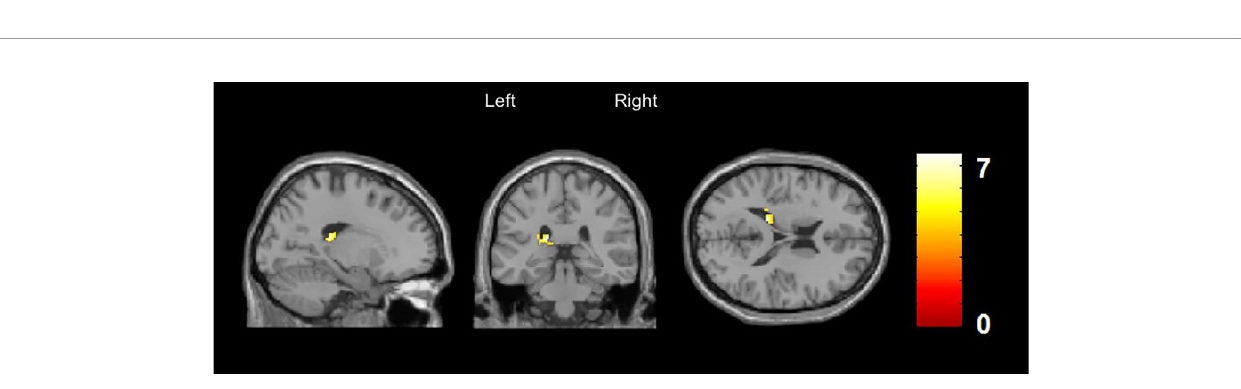
FIGURE 1 | Arterial Spin Labeling analysis for gray matter regional cerebral blood fl ow (rCBF), whole brain, T-contrast in CHR subjects with (n = 21) vs. without (n = 23) DP/DR, uncorrected at p < 0.001 (x/y/z = − 16/42/ − 22, t = 5.3). Red areas indicate signi fi cantly decreased CBF in the left orbitofrontal cortex in the CHR group